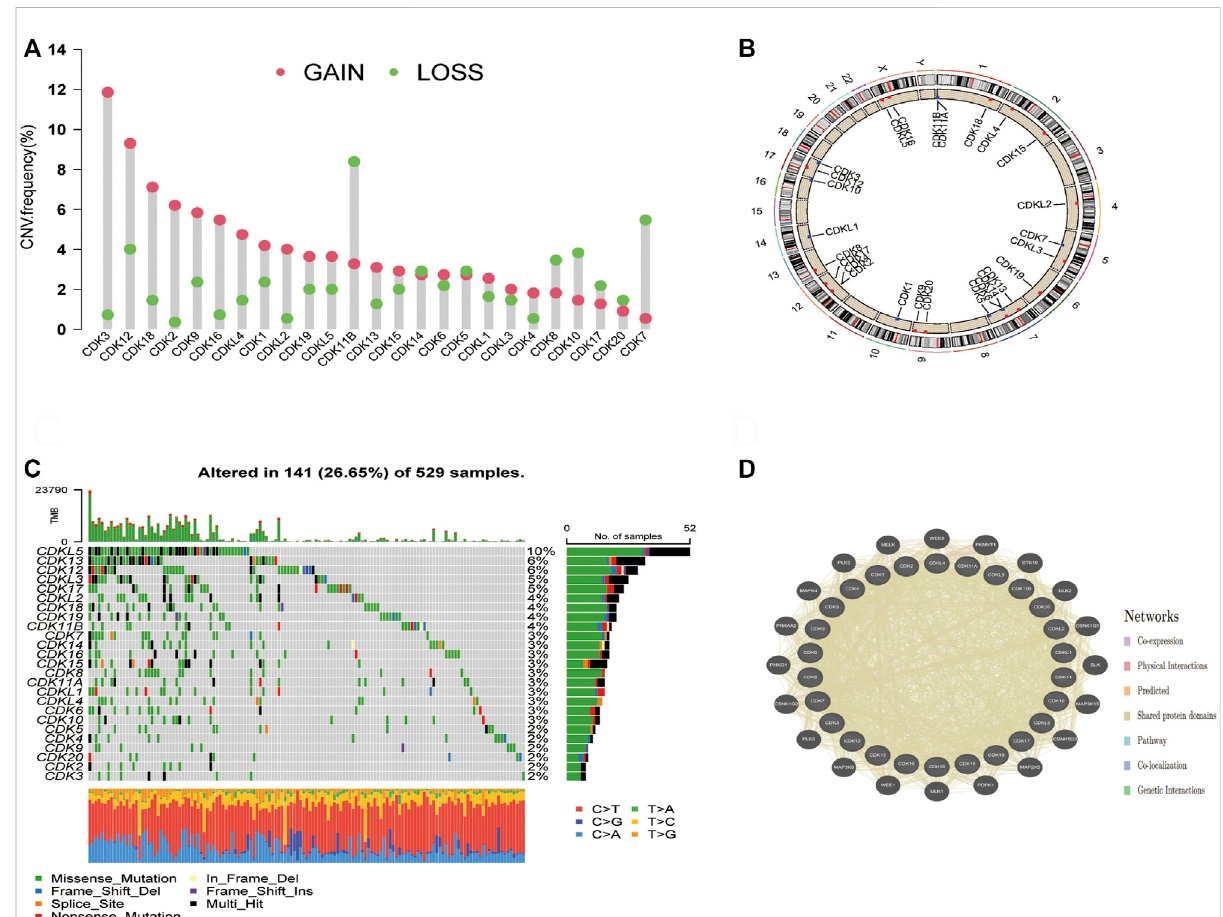
FIGURE 2 Molecular characterisation and genetic variation of CDK family genes in EC. (A) CNV frequenciesof CDK genes in EC. The green dots represent the frequency of copy number deletion, the red dots represent the frequency of copy number ampli fi cation, and the height of the columns represents achange frequency. (B) Location ofthe CNVsof CDK genes on 23chromosomes. (C) Mutation frequencies ofCDK genes in 529patients with EC TCGA database. Each column represents one patient, the bar on the top represents TMB, and the numbers on the right represent the mutation frequency of each CDK gene. The bar on the right represents the proportion of each CDK gene. The stacked bars below represent the proportion of conversation in each sample. (D) Functional interaction network of CDK genes established using the GeneMANIA